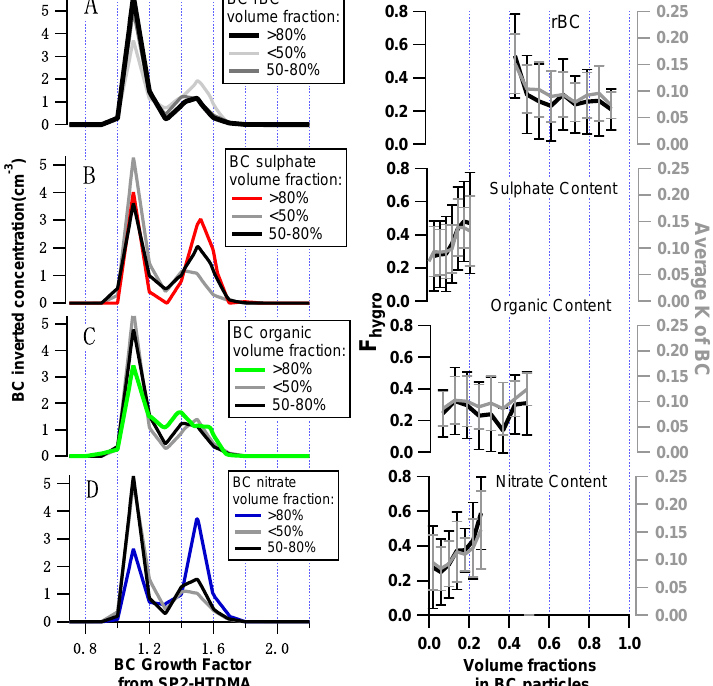
Fig. 8. Trends for entire experiment: left panel shows the gf distributions of BC-containing particles when the volume fractions of each component (rBC, organic, nitrate and sulphate) were > 50% percentile, 50% percentile-80% percentile and > 80% percentile; right panel shows the hygroscopic fraction ( F hygro ) and averaged κ (on right axis) of BC-containing particles as a function of the volume fractions of the particular chemical component, the error bars indicate ± one standard deviation.